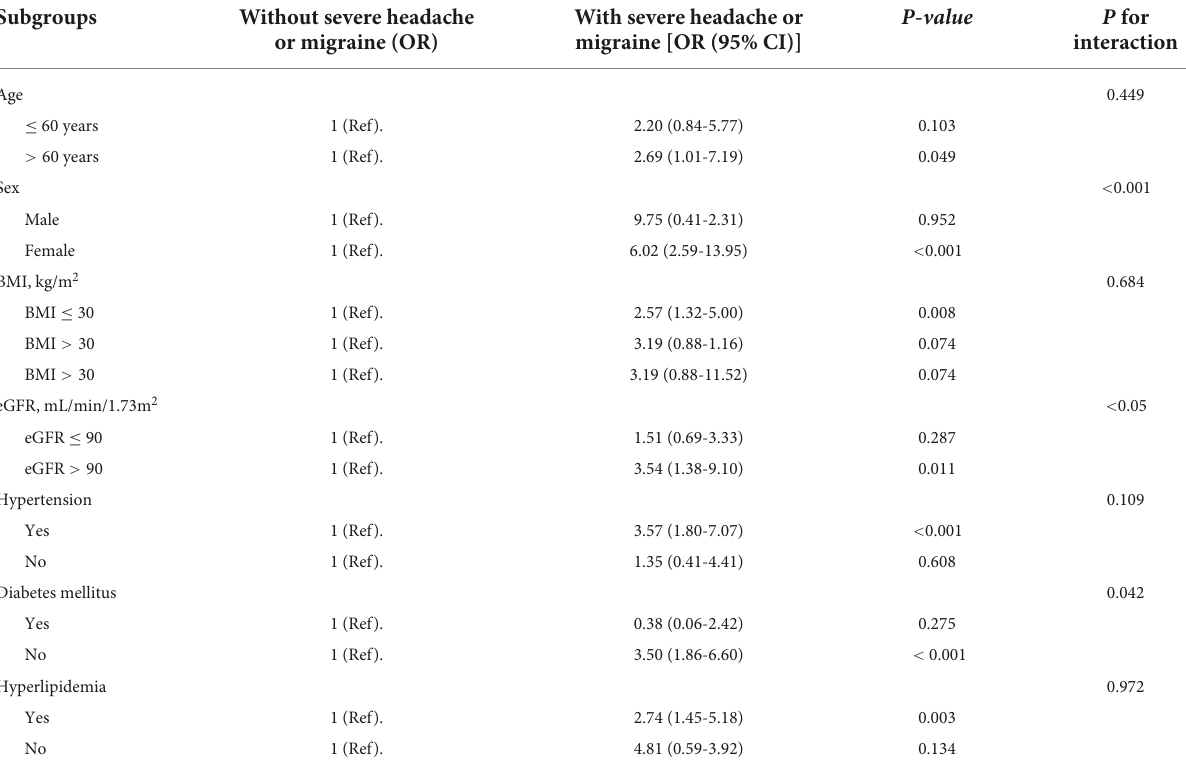
TABLE 4 Subgroups analysis for the associations of severe headache or migraine and CVD